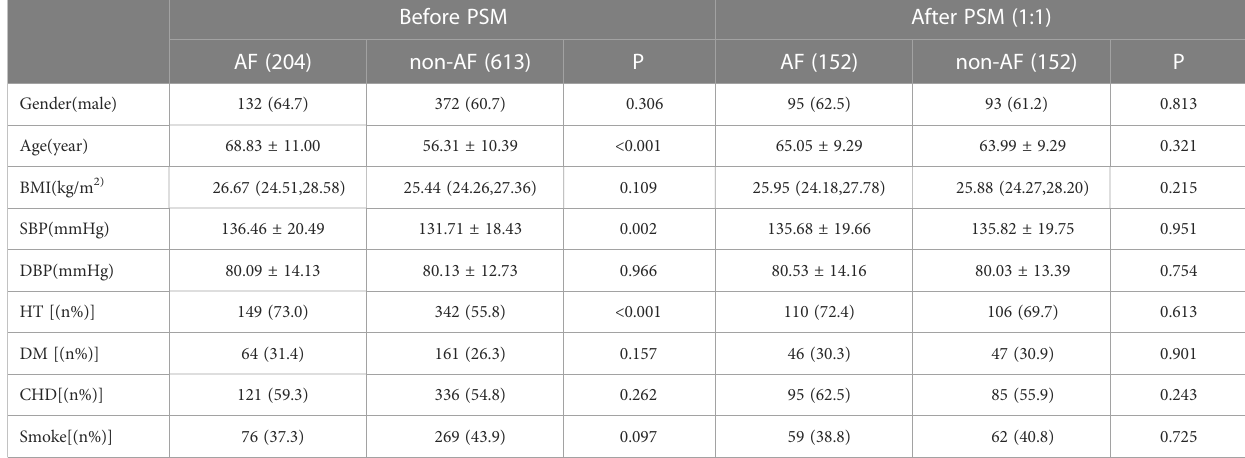
TABLE 1 Baseline characteristics of patients with NAFLD (control) and with NAFLD and AF. Before